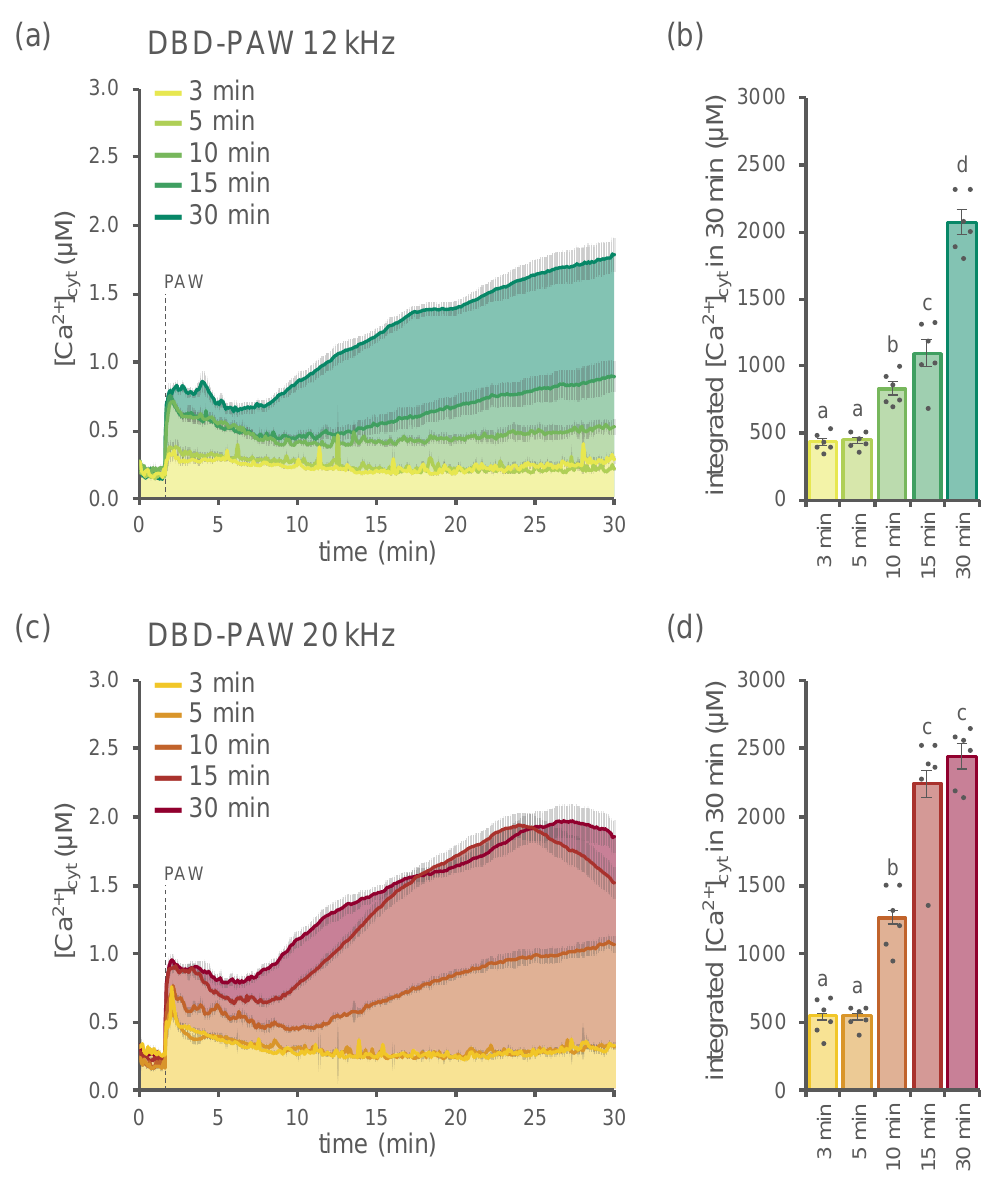
Figure 1. Monitoring of cytosolic Ca 2+ signals triggered in Arabidopsis thaliana (Arabidopsis) in response to DBD-PAW. Variations in the cytosolic Ca 2+ concentration ([Ca 2+ ] cyt ) were measured in 1-week-old Arabidopsis seedlings stably expressing aequorin in the cytosol after the administration (at 100 s, dashed line) of 1:2 dilutions of various DBD-PAWs. The DBD’s discharge frequency was set either at 12 kHz (green shades ( a , b )) or 20 kHz (red shades ( c , d )); for each setting, five different DBD-PAWs were obtained by exposing deionized H 2 O to DBD cold plasma for increasing time intervals (from 3 to 30 min). ( a , c ) Data are the means (solid lines) ± SE (shading) of the [Ca 2+ ] cyt dynamics induced in 6 independent seedlings. ( b , d ) Integrated [Ca 2+ ] cyt dynamics over 30 min. Each dot represents a single biological replicate. Statistical analyses were performed according to Student’s t -test ( p < 0.05), with different letters indicating significant differences.